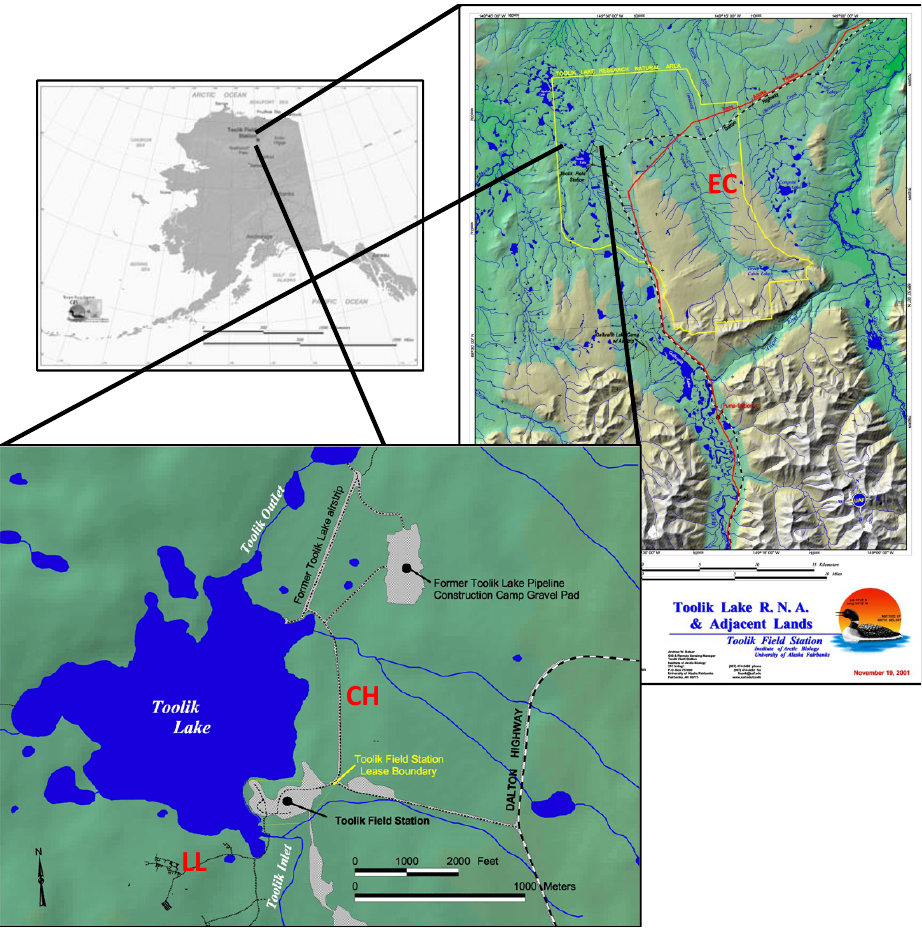
Fig. 1. The Toolik Field Station is located on the north slope of the Brooks Range. The Imnavait Creek experimental watershed (marked EC) is 12km east of the main field station, and is at an elevation of 930m. The chamber measurements were located just north of the field station (marked CH). Leaf-level measurements were performed to the southwest of the station (marked LL). (Map courtesy of the Toolik Field Station GIS Office,